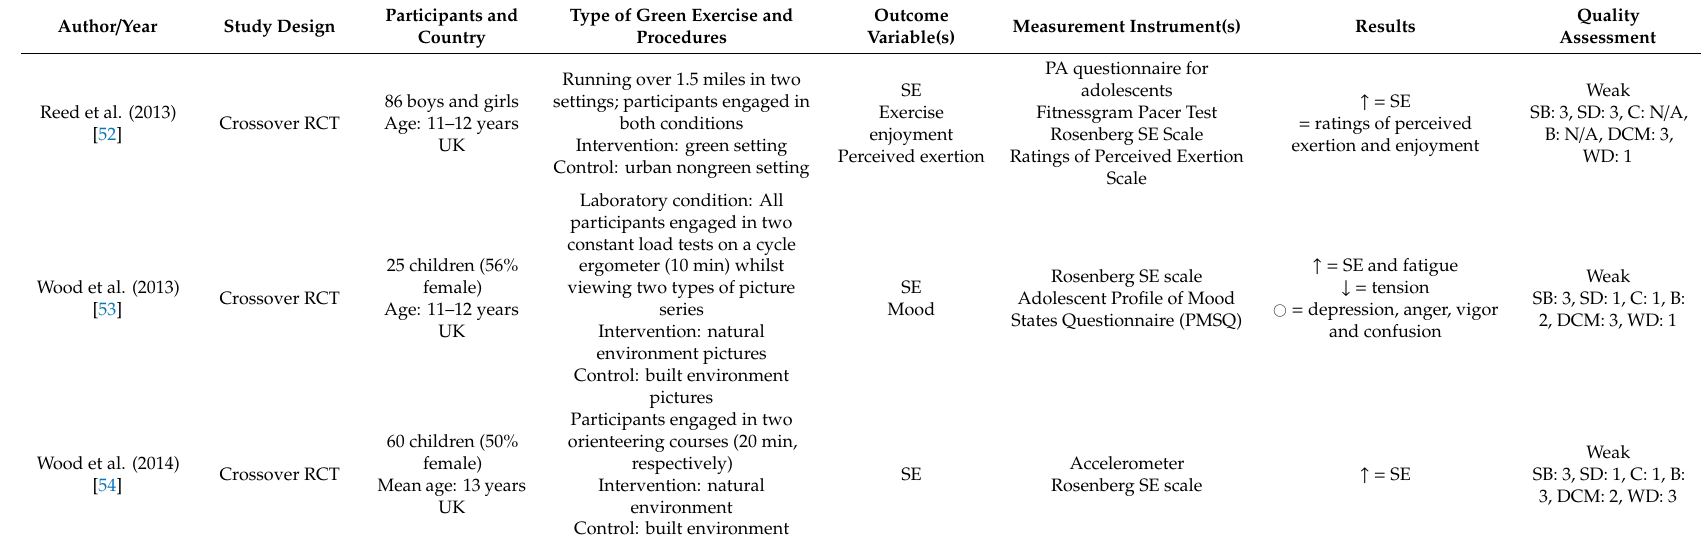
Table legend: ↑ increase; ↑↑ stronger increase / e ff ect in intervention / exposure group compared to control group; control group; ↓ decrease; ↓↓ stronger decrease / e ff ect in intervention / exposure group compared to control group; If = is combined with another symbol (e.g., ↑ = ), this means that both intervention / exposure and control group had the same e ff ect; SE = self-esteem; BP = blood pressure; SB = selection bias, SD = study design, C = Confounders, B = Blinding, DCM = Data collection methods, WD = Withdrawals / Dropouts, N / A = Not